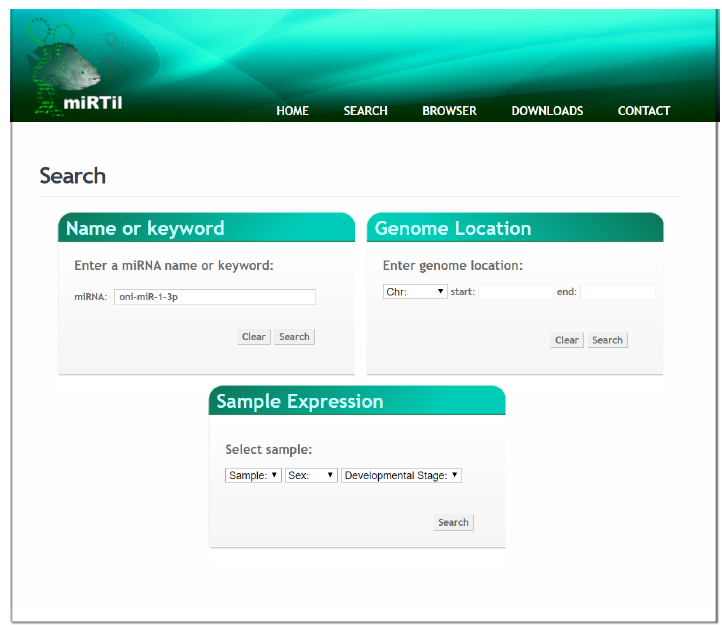
Figure 4. Advanced search mechanism page. The page contains three types of search mechanisms: miRNA symbol name or ID, genomic location, or identified sample.